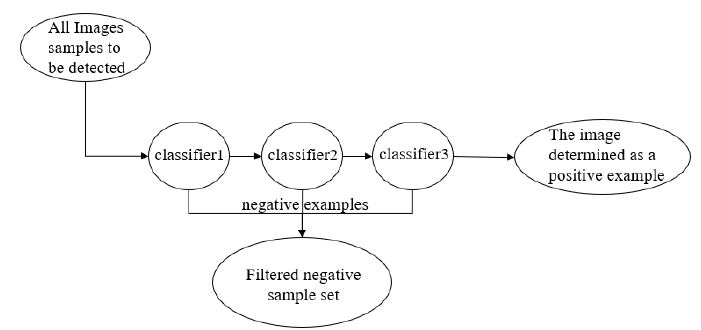
Figure 10. Flow chart of cascade classification.